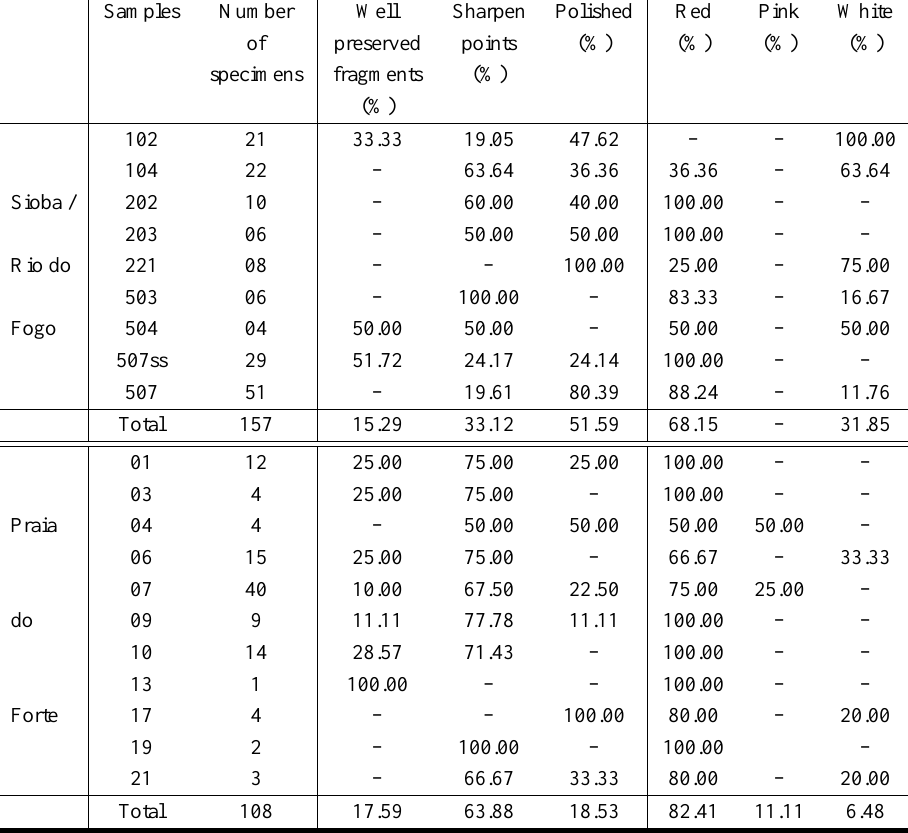
Number of specimens of Homotrema (fragments) and percentage of their major types and colors found in the samples from Sioba/ Rio do Fogo and Praia do Forte